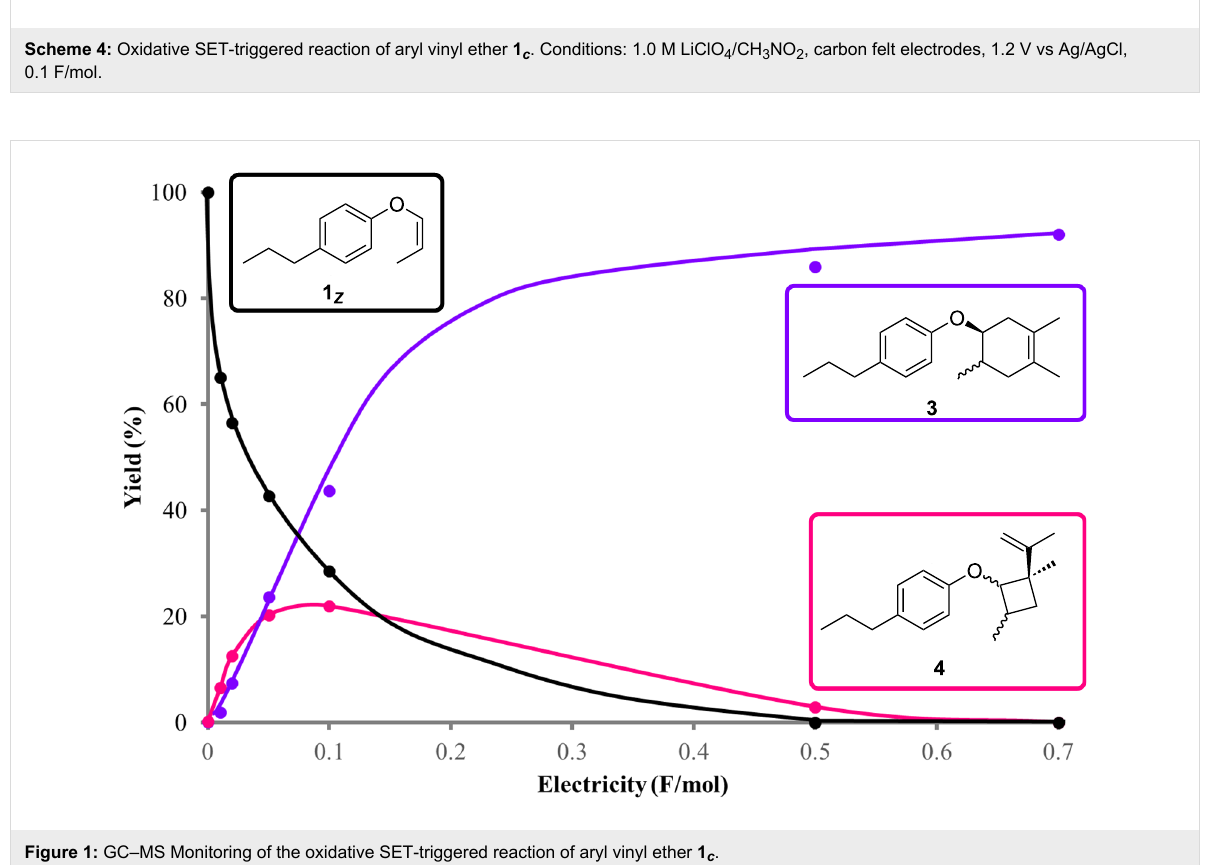
Figure 1: GC–MS Monitoring of the oxidative SET-triggered reaction of aryl vinyl ether 1 c .